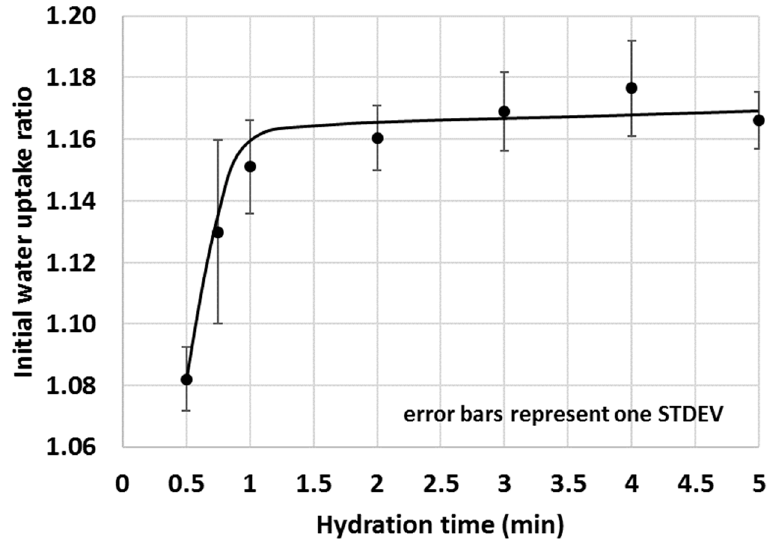
Figure 15. Initial water uptake of 30% calcined clay–OPC blend with time.